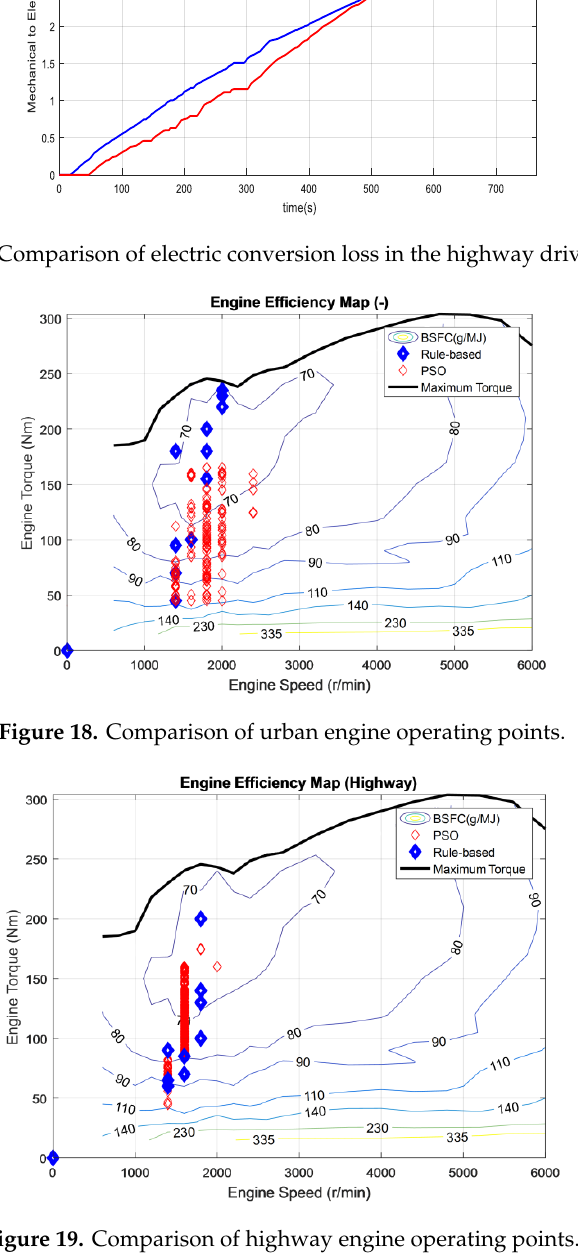
Figure 19. Comparison of highway engine operating points.